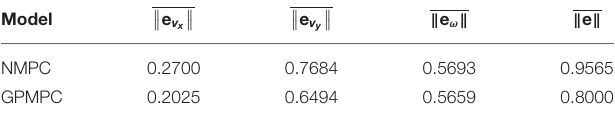
TABLE 4 | MSE comparison in left overtaking.